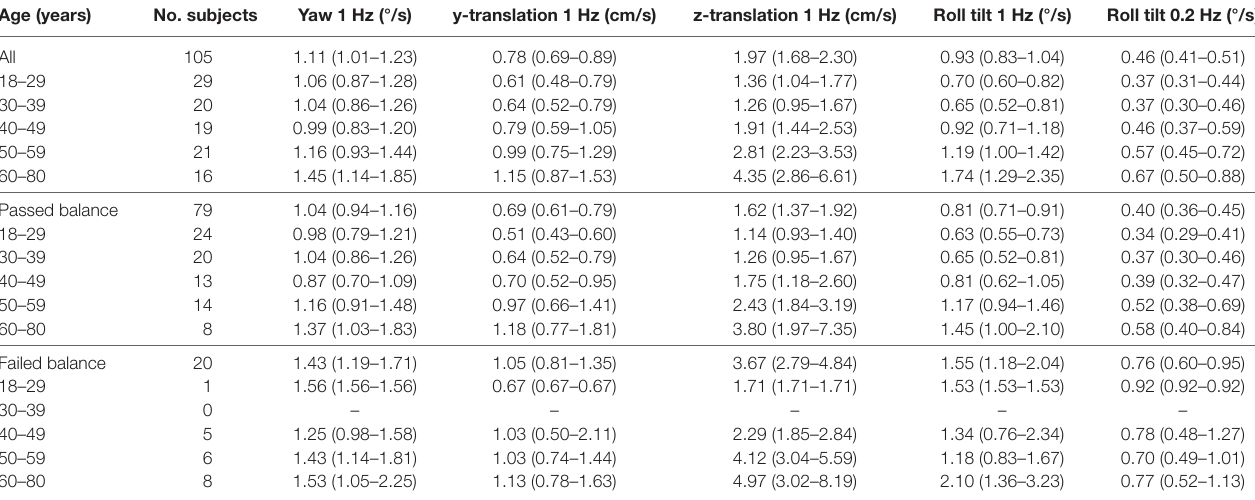
TaBle 1 | Thresholds segmented by age group and results of condition 4 of the balance test, with 95% confidence intervals. age (years)